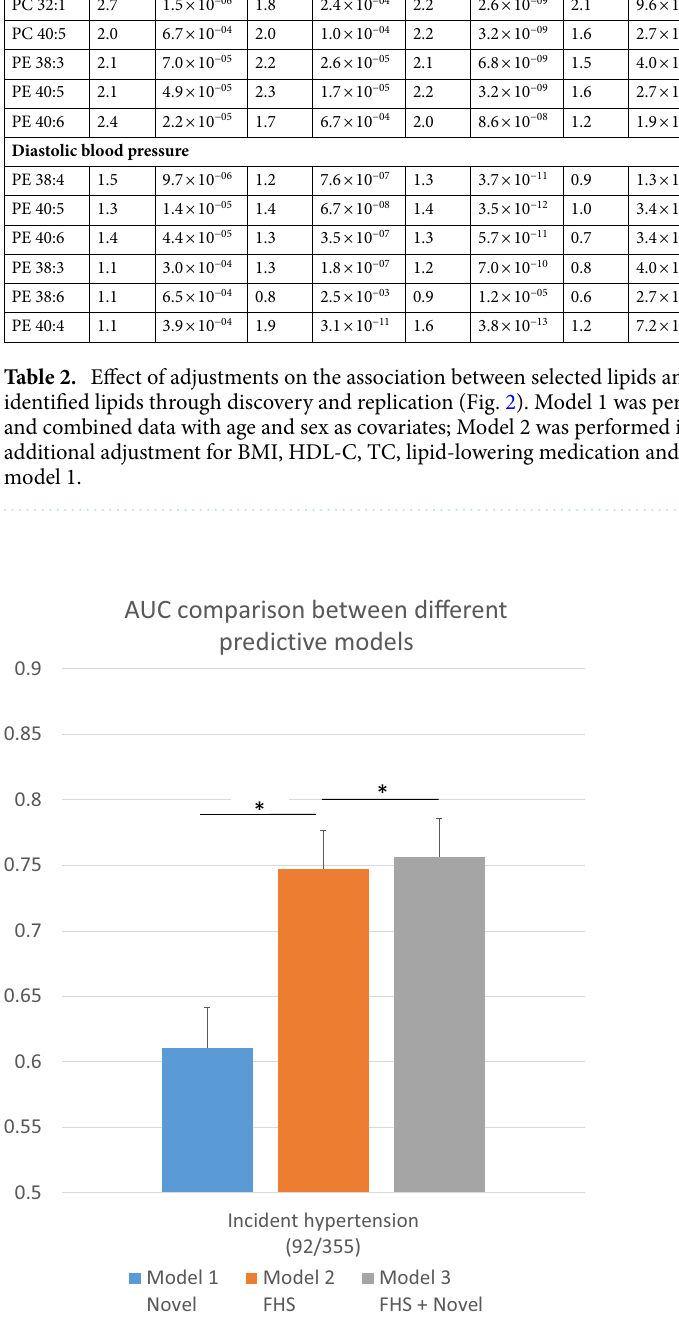
Figure 3. AUC comparison between eight phospholipids associated with either SBP or DBP, the factors included in the Framingham risk score and their combination. Model 1 Novel : The model includes phospholipids associated with either SBP or DBP only: PC 32:1, PC 40:5, PE 38:3, PE 40:6, PE 40:5, PE 38:4, PE 38:6, PE 40:4. Model 2 FHS : The model includes the factors from the Framingham risk scores of incident hypertension: age, sex, SBP, DBP, BMI, cigarette smoking and parental hypertension. Model 3 FHS + Novel : the advanced model adding factors in model 1 and Model 2. * P IDI < 0.05. IDI: Integrated Discrimination Improvement